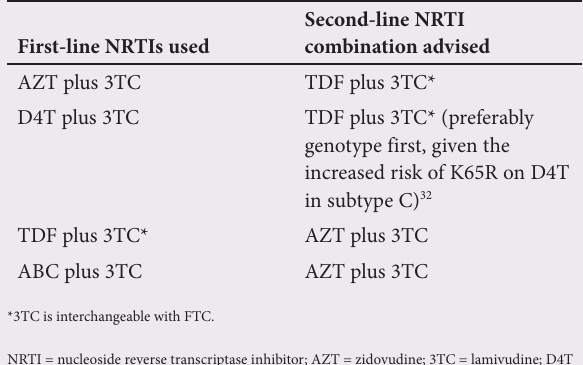
Table 5. Choice of second-line NRTIs in relation to first-line NRTIs used